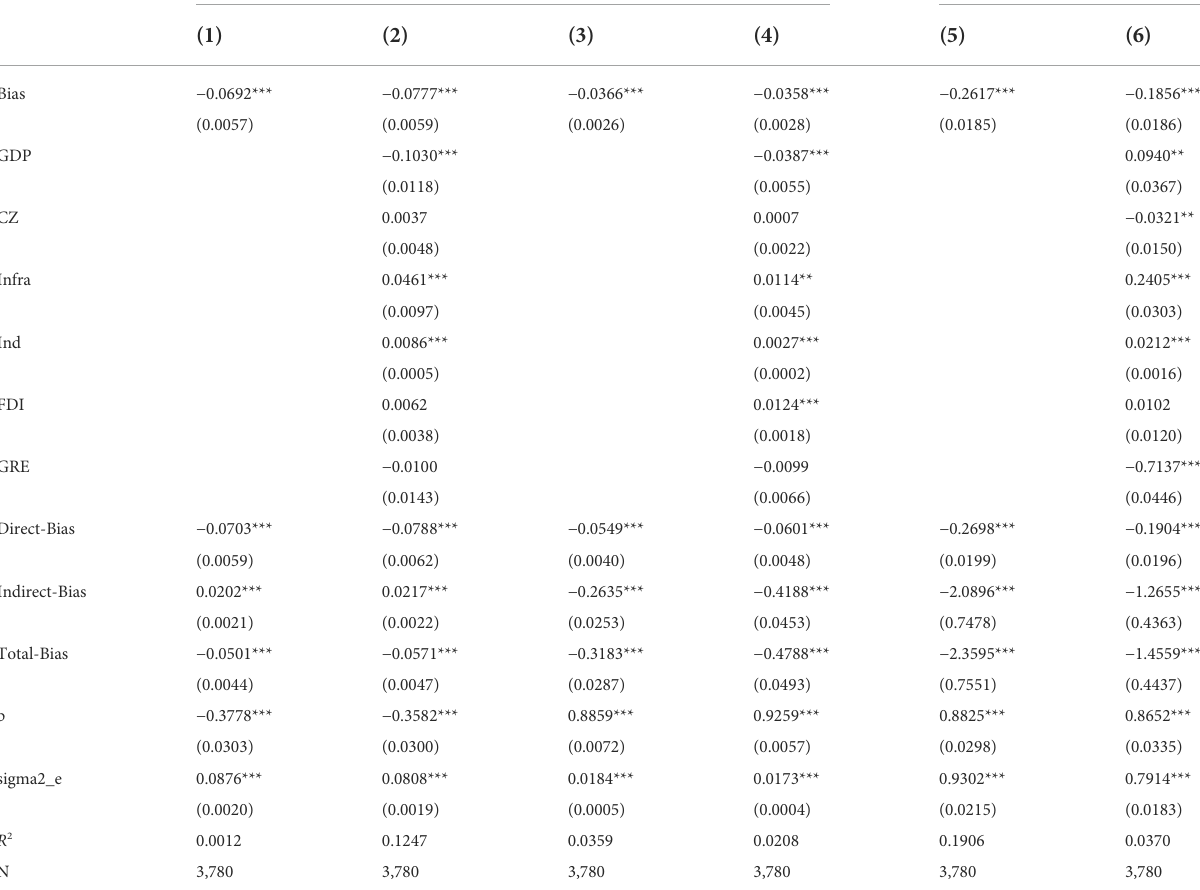
TABLE 5 Robustness